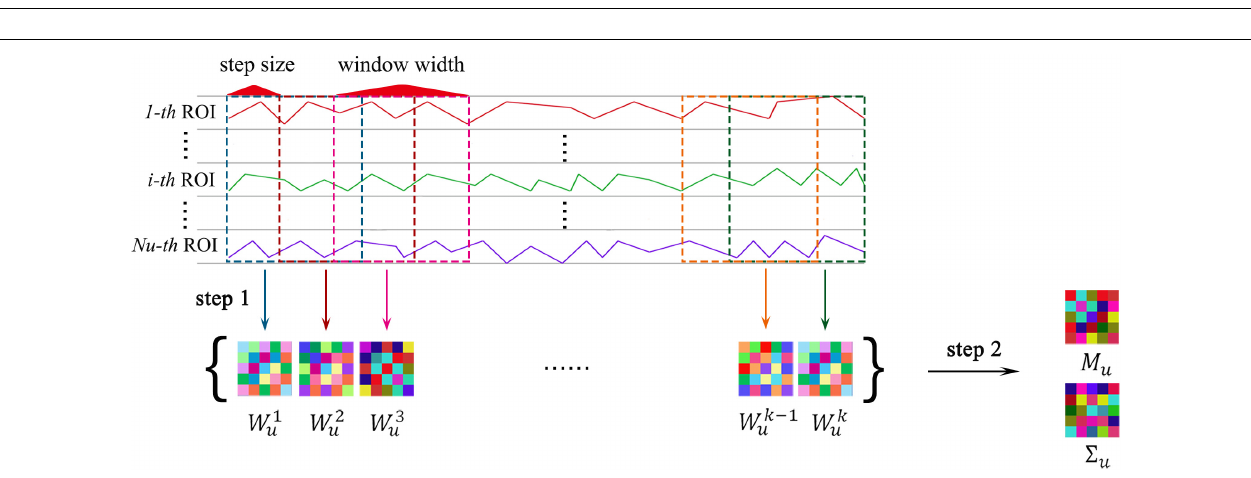
FIGURE 3 | Visualization of the location of each sub-network in brain.